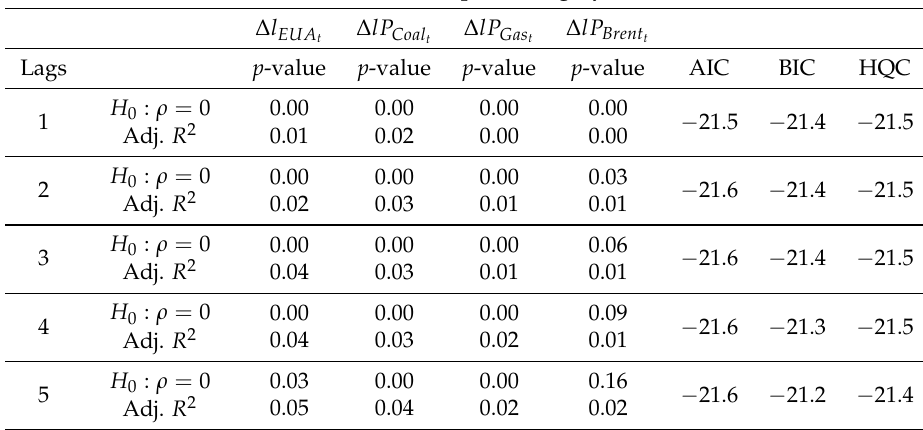
Table 3. Misspecification tests and goodness of fit for the Vector Error Correction Model (VECM) with daily forward